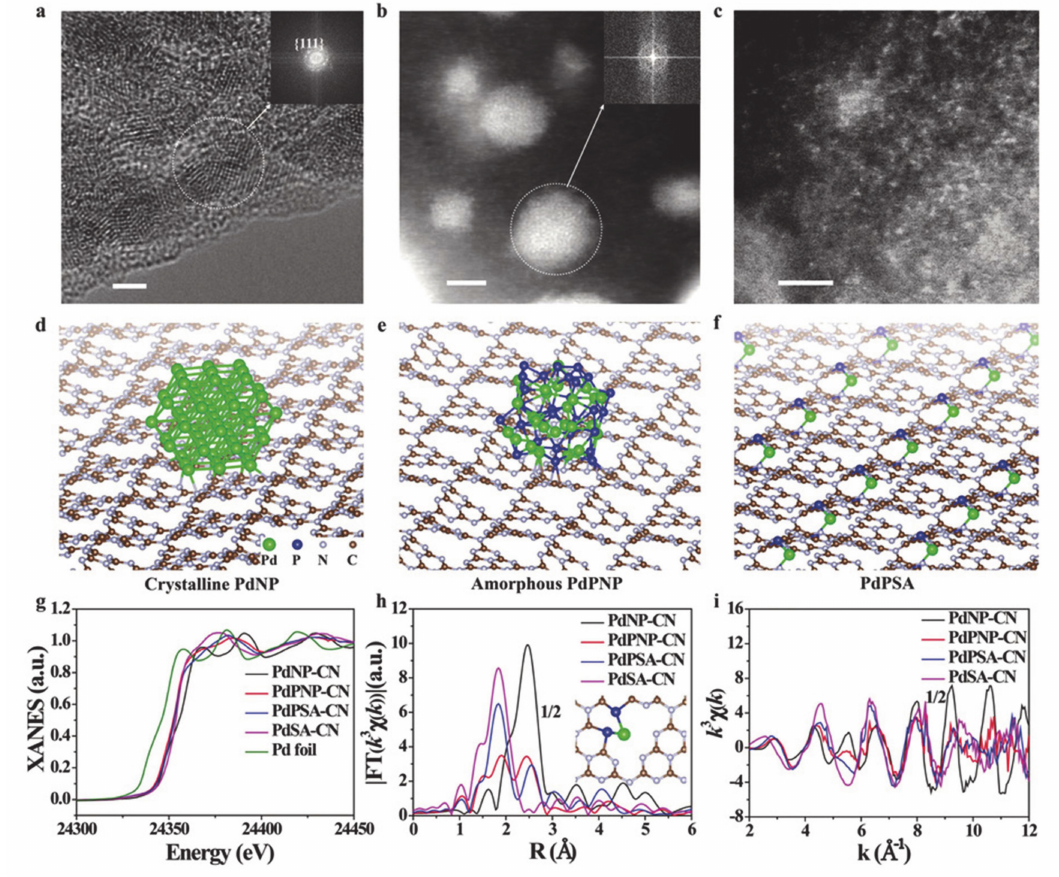
Figure 9. (a ) High resolution transmission electron microscopy (HRTEM) image of PdNP-CN. High angle annular dark field scanning transmission electron microscope (HAADF-STEM) images of ( b ) PdPNP-CN and ( c ) PdPSA-CN. The geometry structures of ( d ) PdNP-CN, ( e ) PdPNP-CN, and ( f ) PdPSA-CN. ( g ) Pd K-edge X-ray absorption near edge structure (XANES) spectra and the corresponding k3-weighted Fourier transform (FT) spectra at ( h ) R and ( i ) k space. Scale bar: 2 nm. Reproduced